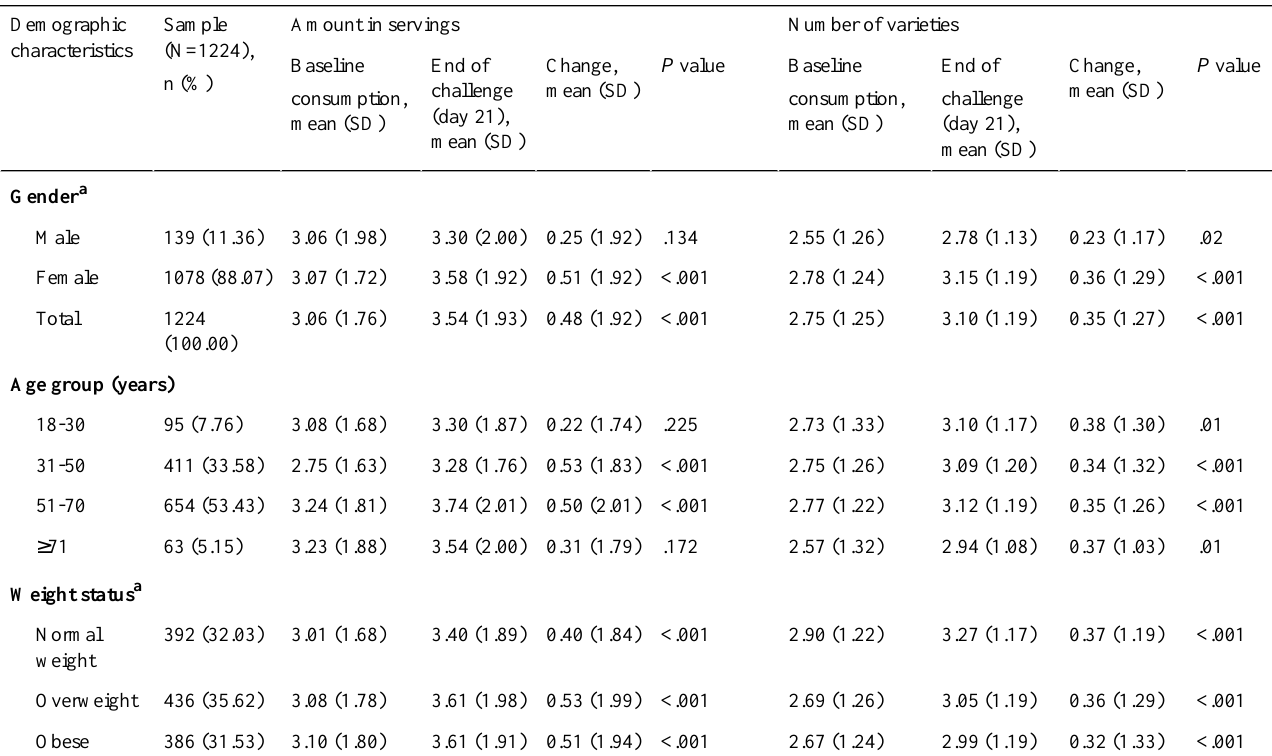
Table 2. Change in vegetable consumption (servings and types) at baseline and at the end of the 21-day challenge by demographic characteristics.